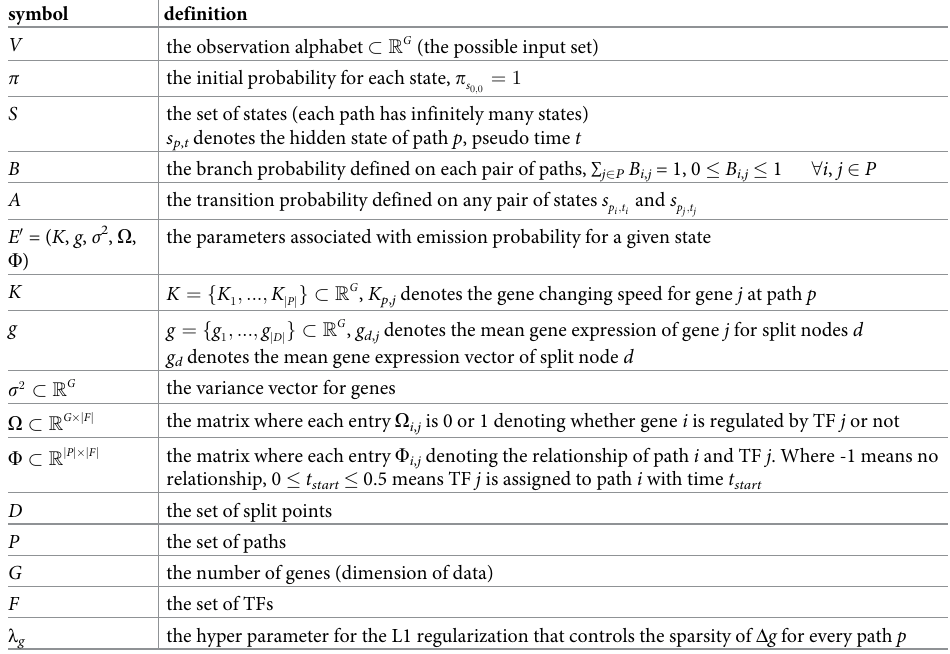
= ( V , π , S , A , E 0 ). CSHMM − TF